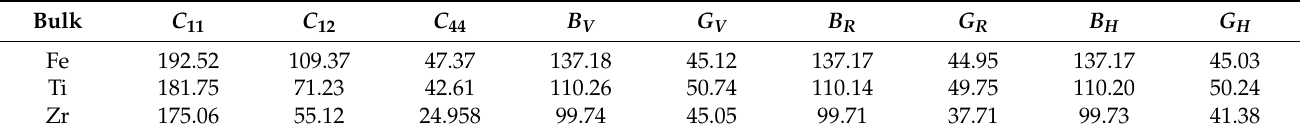
Table 1. Elastic constants for polycrystalline material